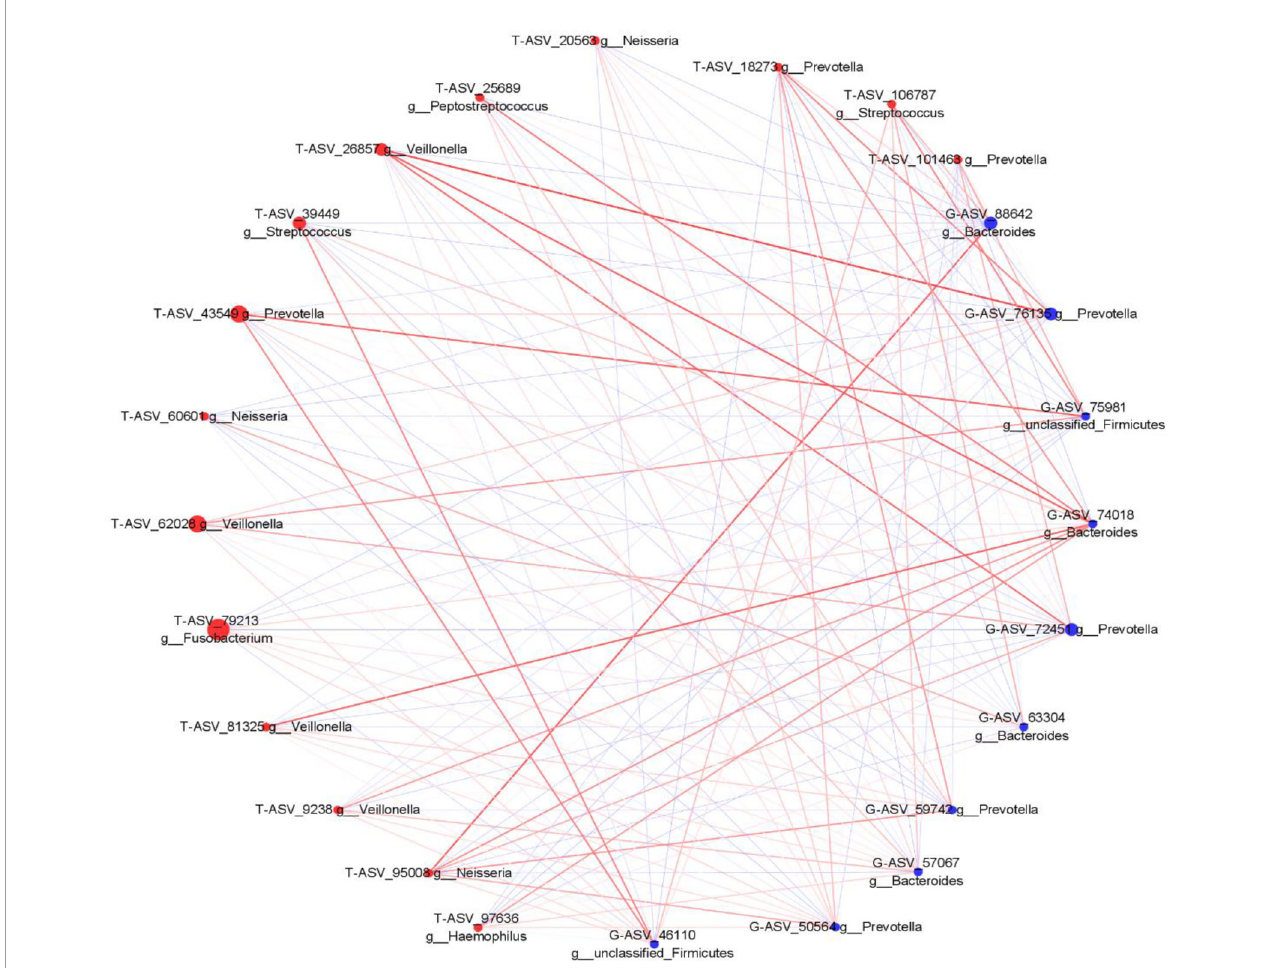
FIGURE 10 | The associated network diagrams of typical tongue coating after sleep and typical intestinal microbiota (red is the tongue coating microbiota, blue is the intestinal microbiota, the size of the circle represents the abundance of the fl ora, the larger the area of the circle, the higher the abundance; the red line represents the positive correlation, the blue line represents the negative correlation, the thicker the line, the higher the correlation coef fi cient).